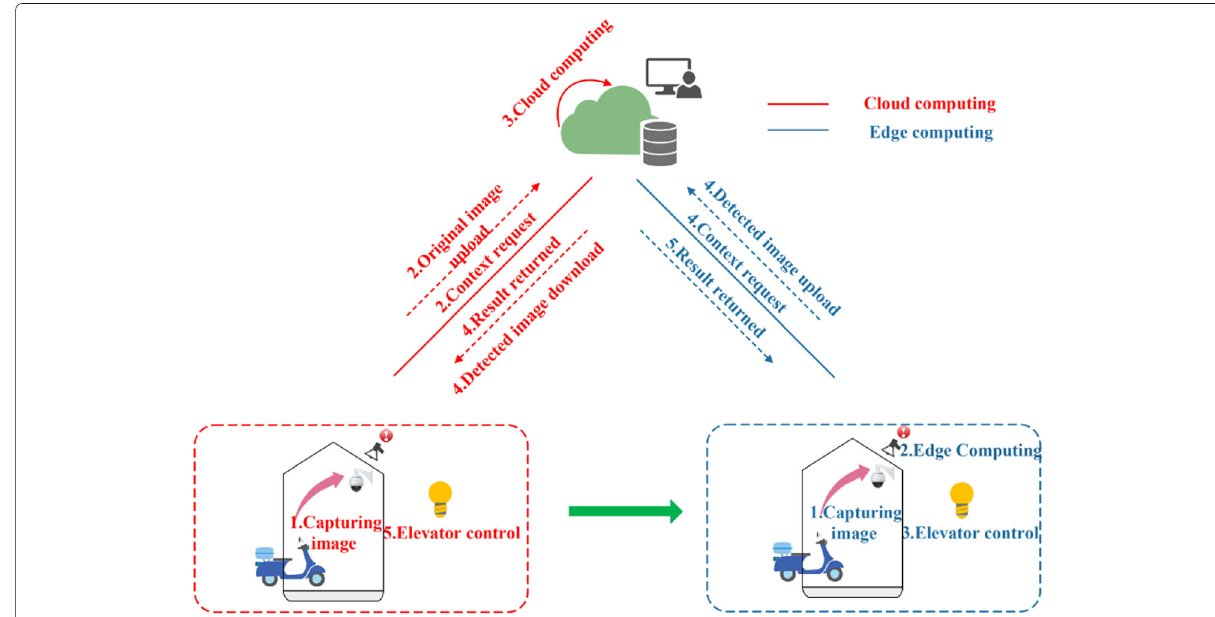
Fig. 11 Differiences between cloud computing and edge computing